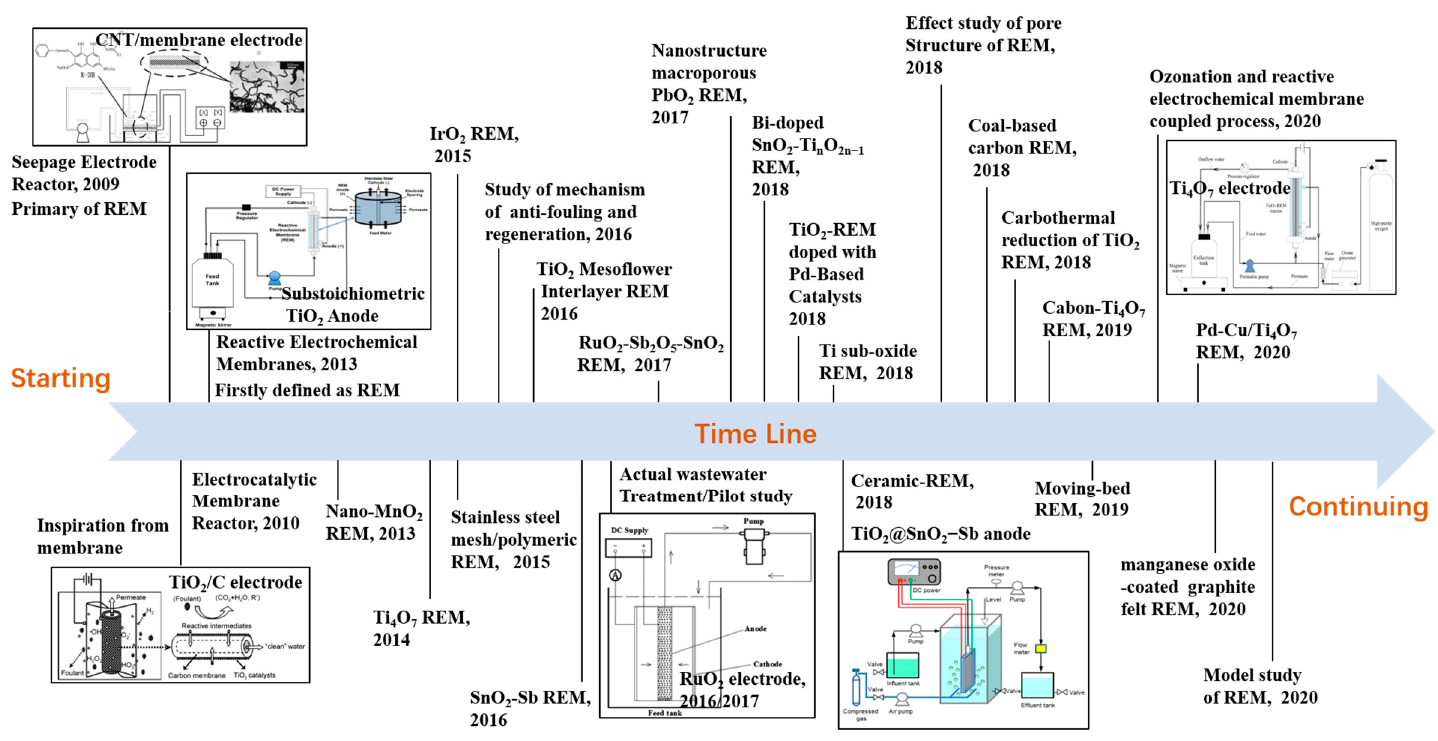
Figure 2. Schematic figure of brief development history of a reactive electrochemical membrane (REM) during 2009–2020 [2,5,6,44–73].